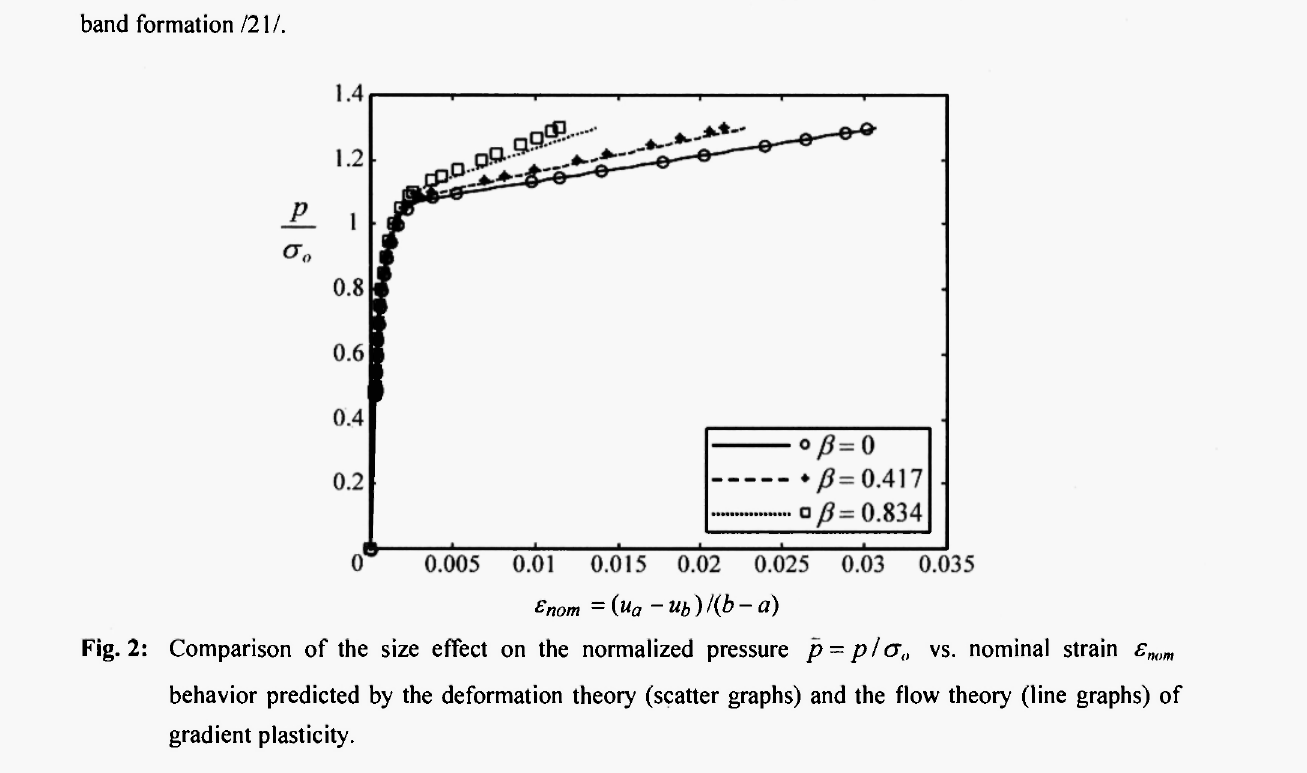
Fig. 2: Comparison of the size effect on the normalized pressure ρ = ρ/σ„ vs. nominal strain £„